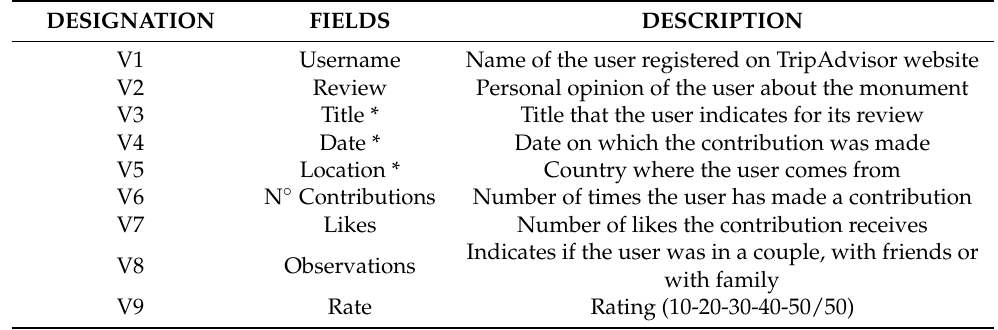
Table 1. Extracted fields from TripAdvisor’s